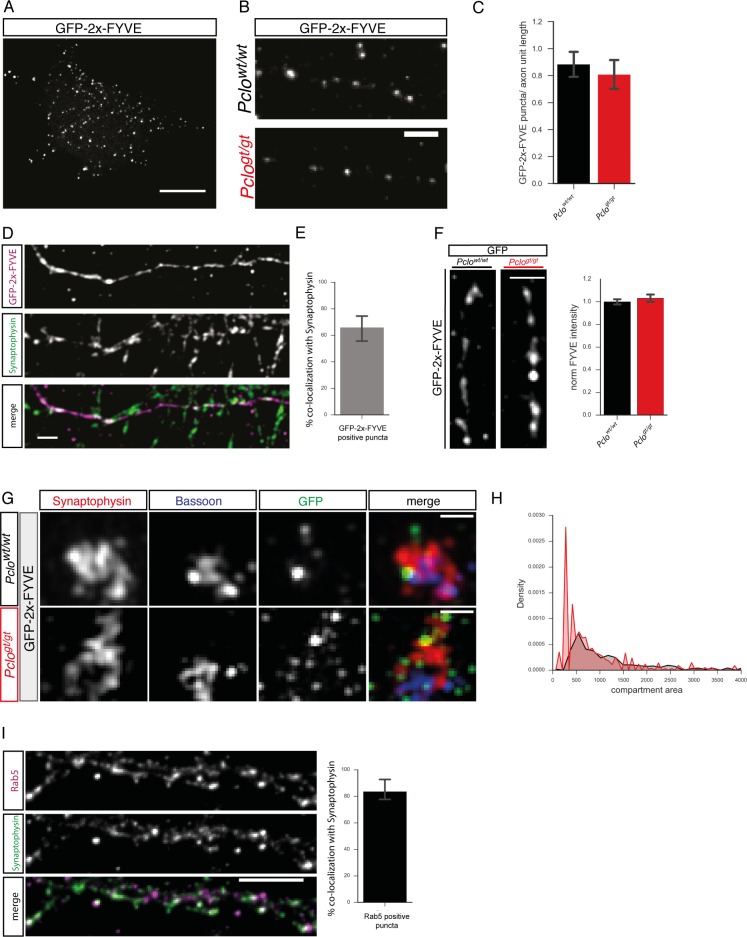
PI3P in Piccolo Pclowt/wt and Pclogt/gt synapses.(A) GFP-2x-FYVE was used as a reporter for PI3P. In HEK293 cells, GFP-2x-FYVE decorates single vesicular early endosomes. (B) Lentiviral expression of GFP-2x-FYVE in primary hippocampal Pclowt/wt and Pclogt/gt neurons decorates small organelles along axons indicating the presence of PI3P. (C) Quantification of (B). The number of GFP-2x-FYVE-positive organelles along axons is not altered in Pclogt/gt compared to Pclowt/wt neurons (Pclowt/wt = 0.88 ± 0.05, n = 39 axons; Pclogt/gt = 0.80 ± 0.05; three independent experiments). (D) Pclowt/wt neurons expressing GFP-2x-FYVE stained for Synaptophysin. Many of GFP-2x-FYVE positive puncta along axons co-localize with synapses marked by Synaptophysin. (E) Quantification of (D). 65.88 ± 5.46% of GFP-2x-FYVE-positive puncta co-localize with Synaptophysin. (F) Images representing GFP-2x-FYVE puncta along axons in Pclowt/wt as well as Pclogt/gt neurons. GFP-2x-FYVE intensity is slightly but not significantly increased in Pclogt/gt neurons (Pclowt/wt = 1 ± 0.02, n = 1516 synapses; Pclogt/gt = 1.03 ± 0.02, n = 1137 synapses; 11 independent experiments). (G) Super resolution structural illumination microscopy (SIM) of Pclowt/wt and Pclogt/gt neurons expressing GFP-2x-FYVE. Synaptic vesicle clusters marked with Synaptophysin (red) can be spatially separated from the active zone protein Bassoon (blue). The PI3P-positive compartment lies above the active zone within the vesicle cluster. The size of GFP-2x-FYVE organelles appears smaller in Pclogt/gt terminals compared to Pclowt/wt terminals. (H) Histogram of the area of the measured GFP-2x-FYVE compartments reveals that the size of GFP-2x-FYVE organelles, in Pclogt/gt neurons, is shifted towards smaller areas (n = 2 independent experiments). (I) % co-localization of Rab5 positive puncta with Synaptophysin. 83,56 ± 4.67% of Rab5 positive puncta co-localize with Synaptophysin (three independent experiments). Scale bar in A, B and D represents 10 μm. Scale bar in F represents 500 nm. Error bars in bar graph represent 95% confidence intervals. Numbers given represent mean ± SEM, Student`s t-test.